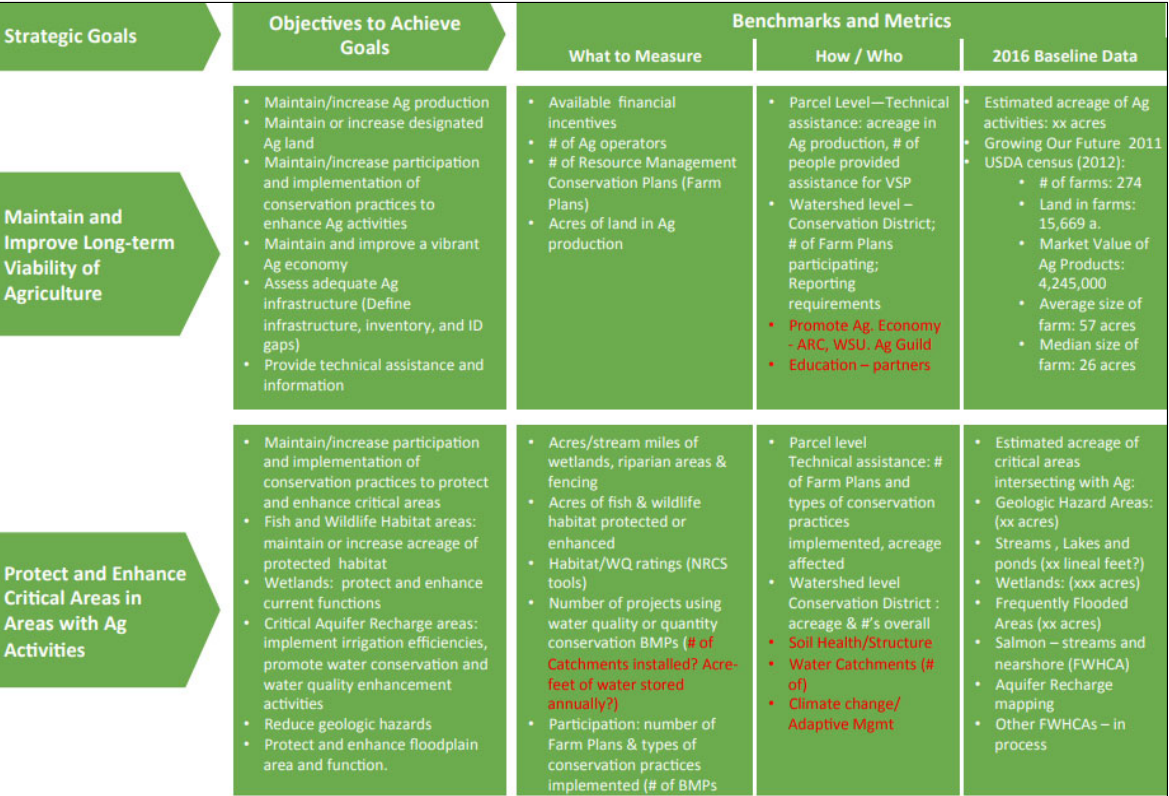
Figure 3. April 2016 Voluntary Stewardship Program Agricultural Viability Goal and Benchmarks Logic